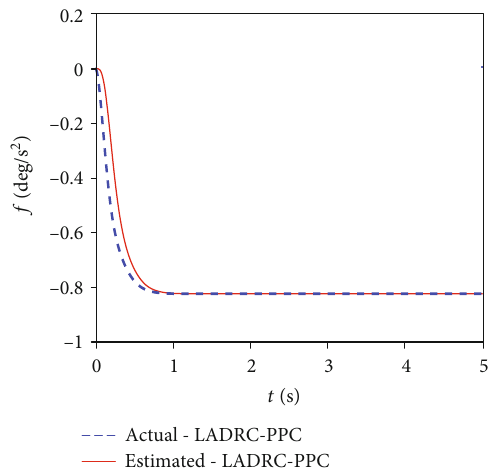
Figure 8: Estimation of f with LADRC-PPC.